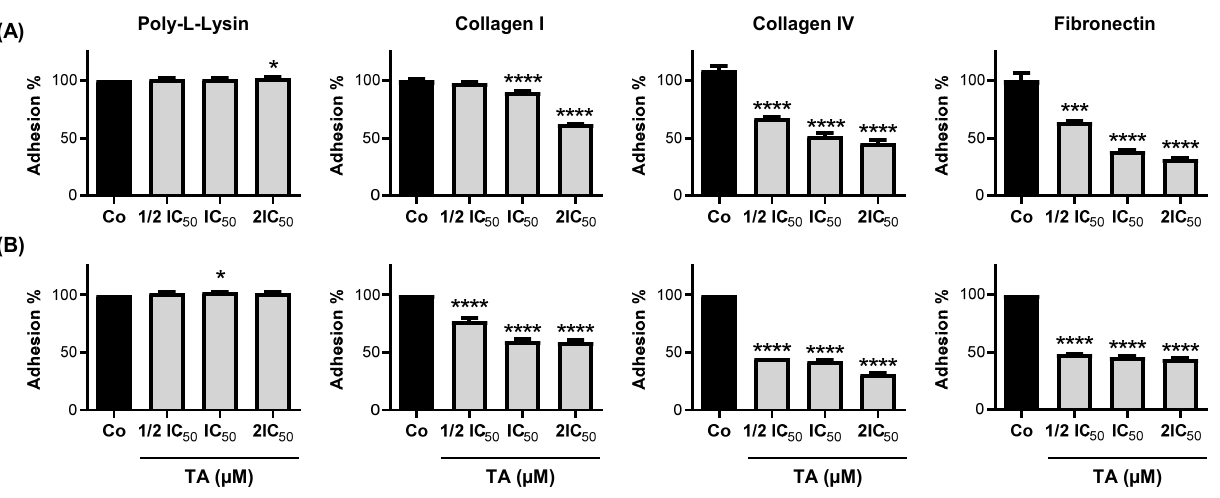
Figure 2. TA inhibits CRC cell adhesion. SW480 ( A ) and CT26 ( B ) cells were exposed for 30 min to 3 different IC 50 -related doses of TA (SW480 cells: IC 50 = 12 µM, ½ IC 50 = 6 µM, and 2IC 50 = 24 µM; CT26 cells: IC 50 = 11 µM, ½ IC 50 = 5.5 µM, and 2IC 50 = 22 µM) and seeded on poly-L-Lysin, type I or type IV collagen (collagen I and collagen IV, respectively), and fibronectin pre-coated wells to eval- uate ECM protein-dependent cell adhesion. After 48 h, the percentage of attached cells was deter- mined by CV assay. The results are expressed as the percentage of solvent control (DMSO, Co) (mean ± SD) of 3 independent experiments performed in triplicate per condition. Statistical signifi- cance was determined by one-way ANOVA, followed by Tukey’s test for multiple comparison tests, with p < 0.05 (*), p < 0.001 (***), and p < 0.0001 (****) vs. the corresponding control group.